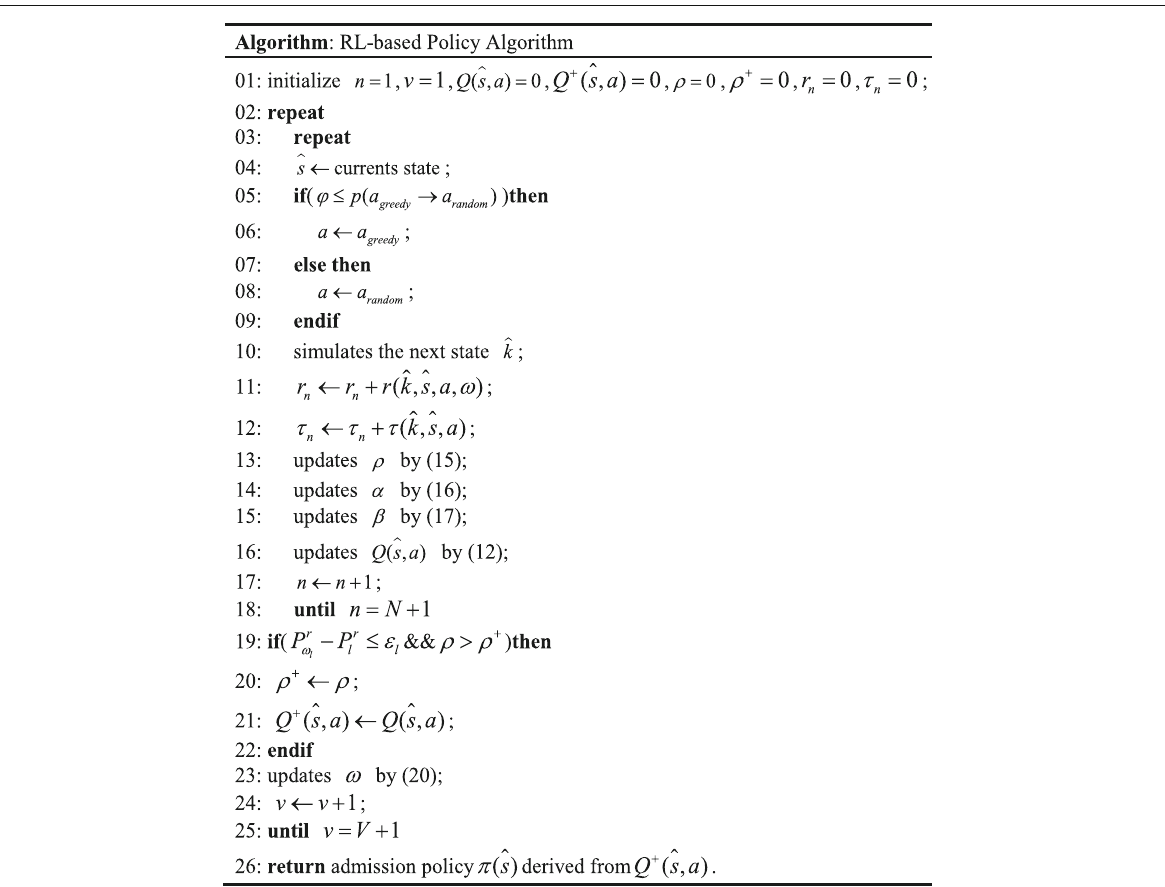
function as the optimal action. In the learning process, the QoS constraint should be considered, and thus, the system state is modified to handle the QoS constraint. As the core